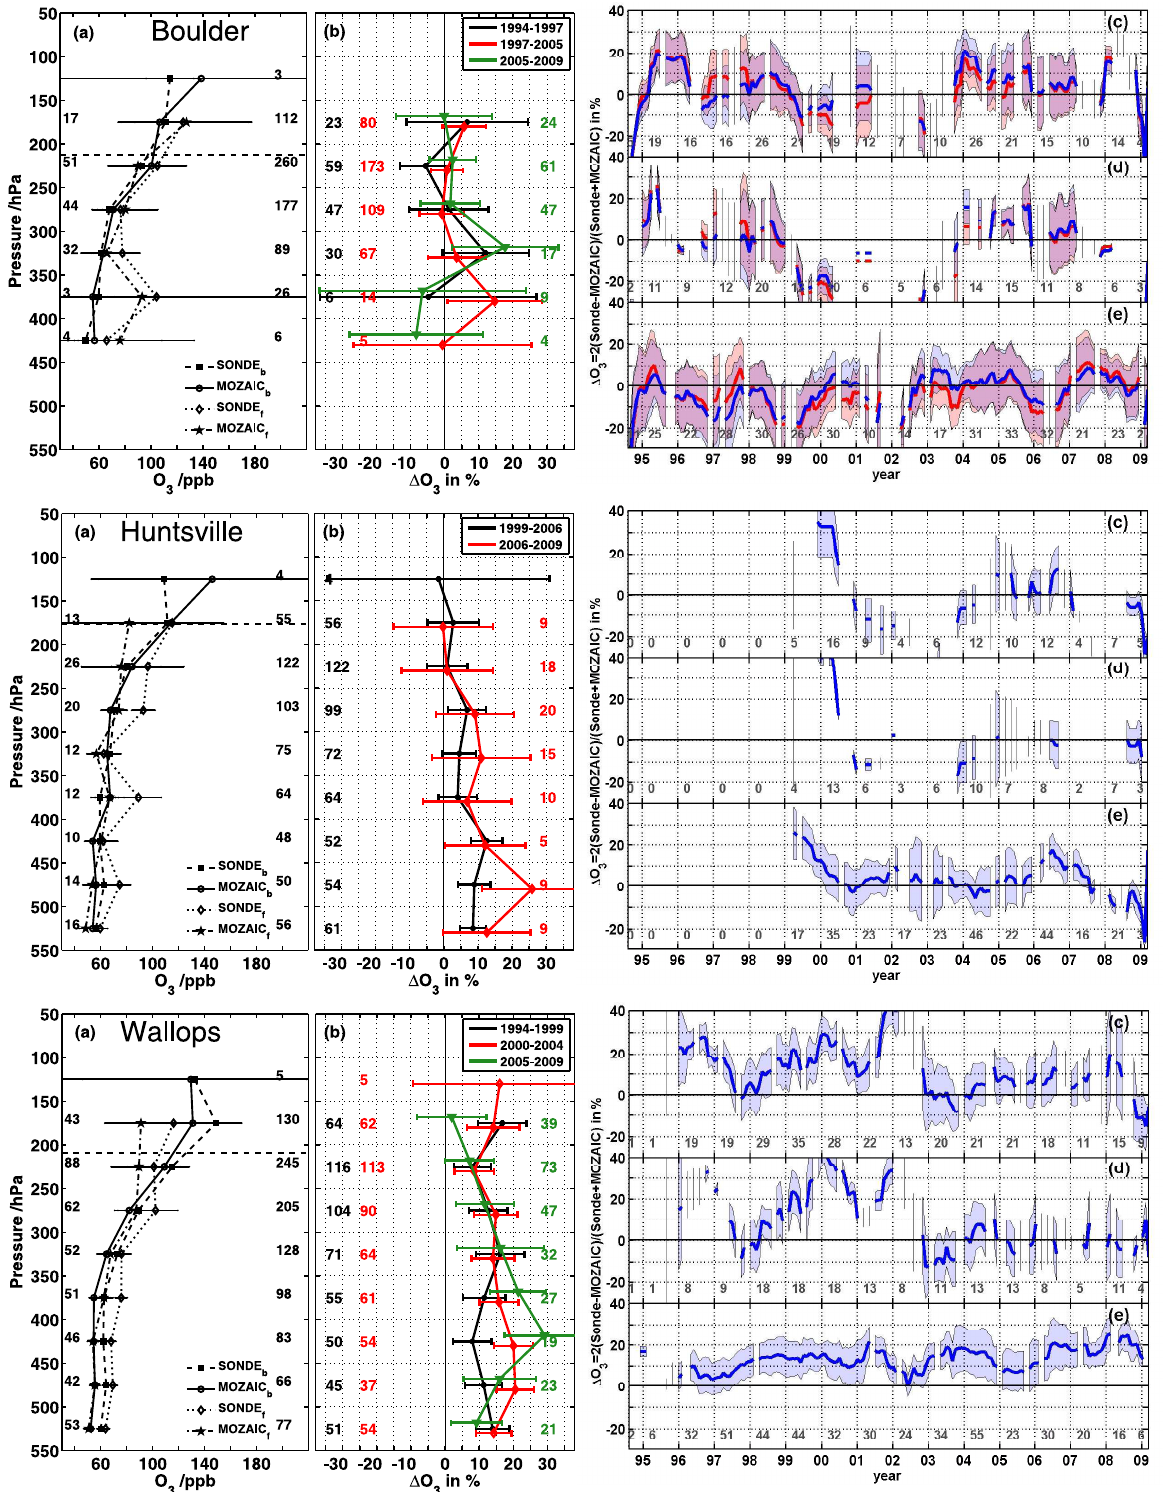
Fig. 9. Comparison of ozonesondes with MOZAIC measurements. As for Fig. 3, but for Boulder, Huntsville, and Wallops Island. For each period in (b) a different sensing solution was used at Boulder and Huntsville. 46